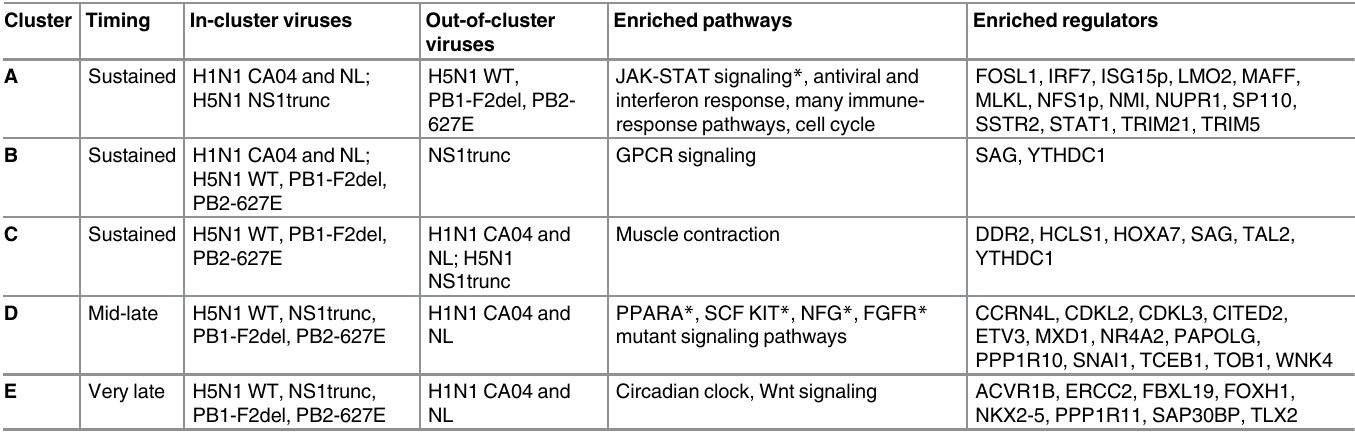
Table 6. Characterization of time- and virus-specific